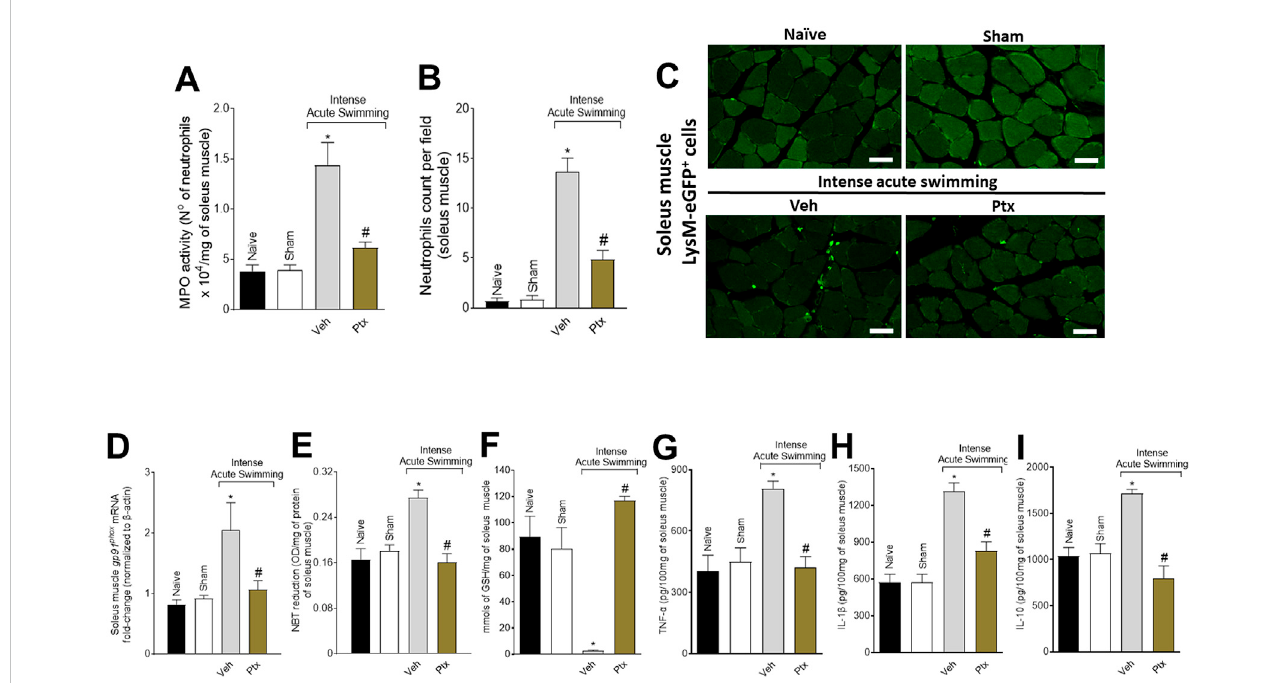
FIGURE 2 Ptx reduces DOMS recruitment of neutrophils, oxidative stress, and cytokine production in the soleus muscle. Ptx (4.5 mg/kg dose; i.p.) inhibits intense acute swimming – induced (A) MPO activity, (B,C) LysM-eGFP + neutrophil recruitment, (D) gp91 phox mRNA expression, (E) superoxide anion production, (F) GSH, (G) TNF- α , (H) IL-1 β , and (I) IL-10 levels. Results are presented as the number of neutrophils ×10 4 per milligram of muscle for MPO activity, neutrophil counts per fi eld, muscle mRNA fold-change normalized to β -actin for gp91 phox expression, as NBT reduction (OD per milligram of protein of muscle for superoxideanionproduction),millimolspermilligramofmuscleforGSHlevels,andpicogramsper100 mgofmuscleforcytokinelevels( n =6micepergroup per experiment and is representative of two independent experiments). Scale bar: 50 µm * p < .05 when compared with control groups, # p < .05 when compared with Veh group (one-way ANOVA followed by Tukey ’ s post hoc